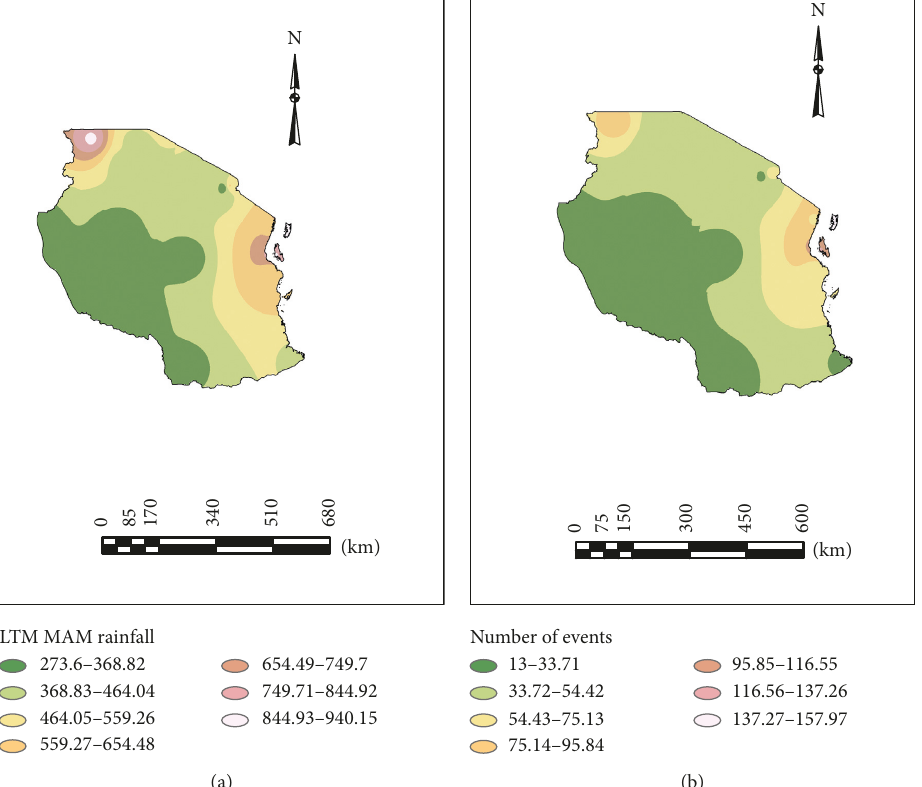
Figure 1: Spatial distribution pattern for (a) long-term mean of MAM rainfall (mm) and (b) number of HREs based on 1980–2010